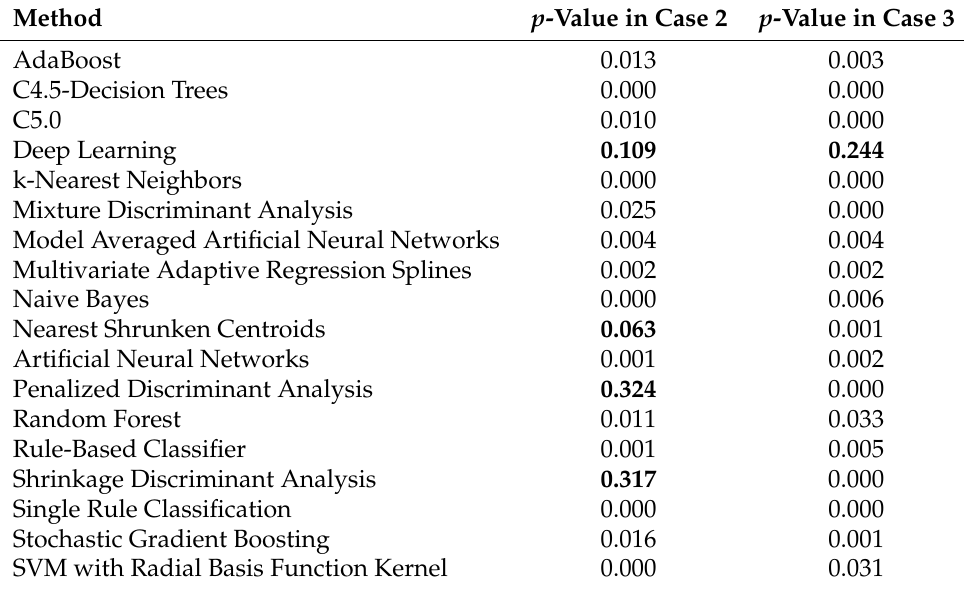
Table 11. Results of the t -test analysis reporting the p -values or cases 2 and 3. Bold values represent p -values greater than 0.05 (95% confidence